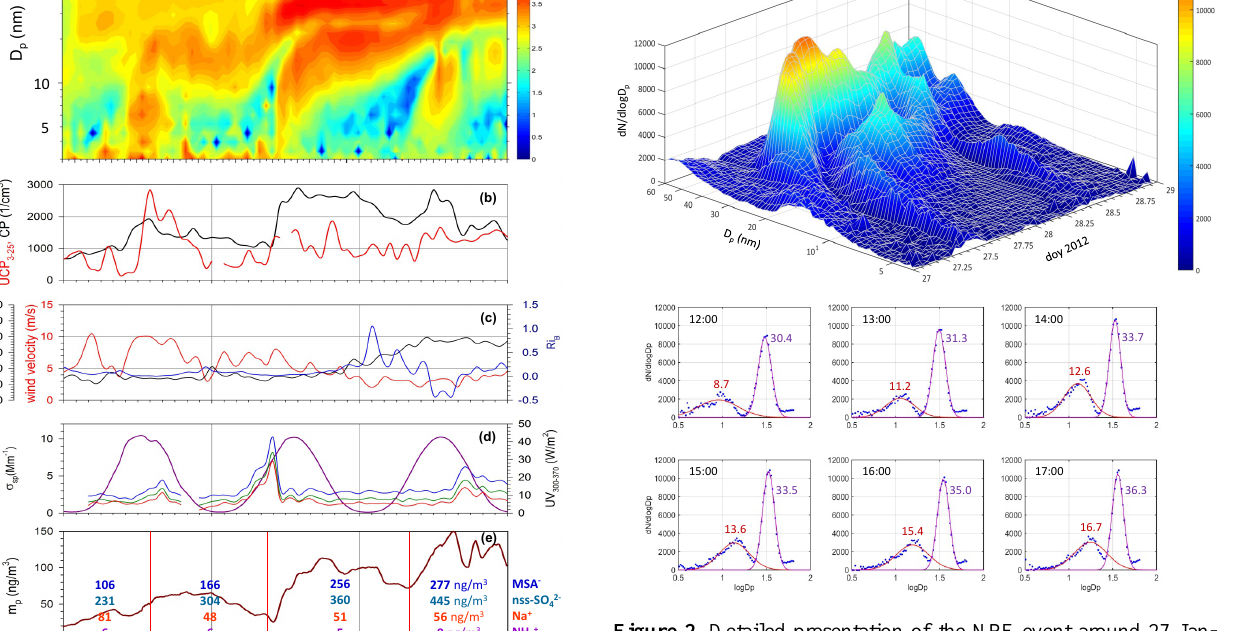
Figure 2. Detailed presentation of the NPF event around 27 Jan- uary 2012 with a linear d N / dlog D p (cm − 3 ) scale as z axis, based on hourly mean SMPS data recorded with 64 channel resolution. Figure 1. Time series of the measured particle size distribution The lower panel shows exemplarily six log-normal distribution fits d N / dlog D p (cm − 3 ) on a logarithmic scale (colour code to the right through size distributions measured on 27 January between 12:00 of the contour plot) of NPF events around 27 January 2012 showing and 17:00UTC. The mode mean diameters (in nm) are noted next a growing nucleation and Aitken mode (a) , corresponding CP con- to the respective modal centration (black line) and particle concentrations between 3 and 25nm (UCP 3–25 , red line) (b) , wind velocity (red line), wind direc- tion (black line) and Ri B (blue line) (c) , light scattering coefficients σ sp at 450, 550, and 700nm (blue, green and red lines) as well as UV radiation at wavelengths between 300 and 370nm (purple line) (d) , and aerosol mass m p derived from SMPS measurements assum- ing a density of 1.8gcm − 3 , as well as MSA − , nss-SO 2 − , Na + , and 4 NH + concentrations derived from daily aerosol samples (red lines 4 mark the time of filter exchange) (e) .